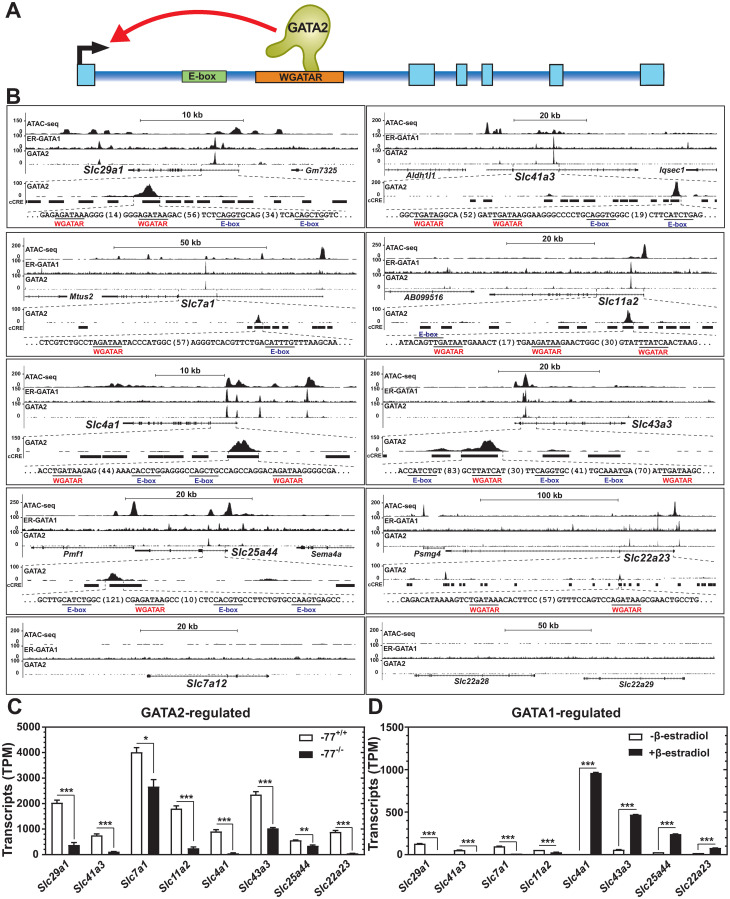
An SLC cohort with GATA factor occupancy at predicted intronic enhancers.(A) Model depicting direct GATA2 regulation via intronic enhancers with WGATAR and E-box motifs. (B) ATAC-seq (GEO GSE114996) [39] and ChIP-seq profiles (GEO GSE30142, GEO GSE29196) [38, 40] of GATA1/2 co-regulated SLC genes (Slc29a1, Slc41a3, Slc7a1, Slc11a2, Slc4a1, Slc43a3, Slc25a44, and Slc22a23), and control genes (Slc7a12, Slc22a28 and Slc22a29) in G1E or G1E-ER-GATA1 cells. The GATA2 ChIP-seq peak is enlarged to illustrate candidate cis-regulatory elements (black bars)[41], WGATAR motifs (underlined, red text), and E-Box motifs (underlined, blue text). (C) RNA abundance measured by RNA-seq with Gata2–77-/- and -77+/+ erythroblasts (n = 3). (D) RNA abundance measured by RNA-seq with untreated or 48-hour β-estradiol-treated G1E-ER-GATA1 cells (n = 3).